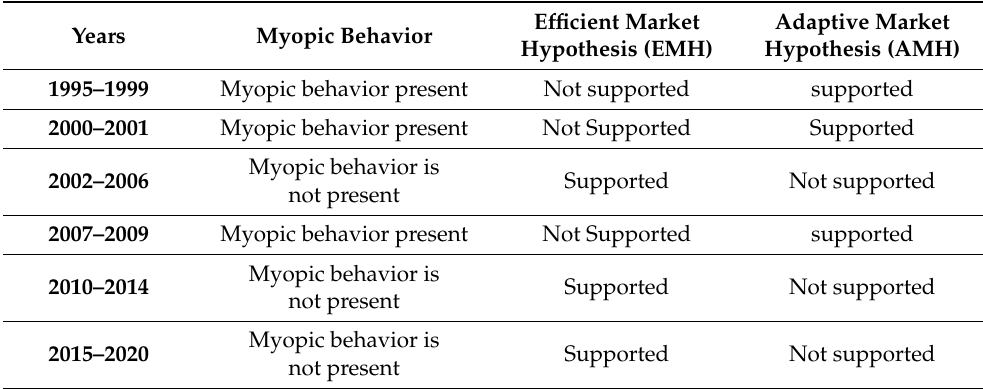
Table 4. Overall results in terms of myopic loss aversion, Efficient Market Hypothesis, and Adaptive Market Hypothesis by using LPM ratio.